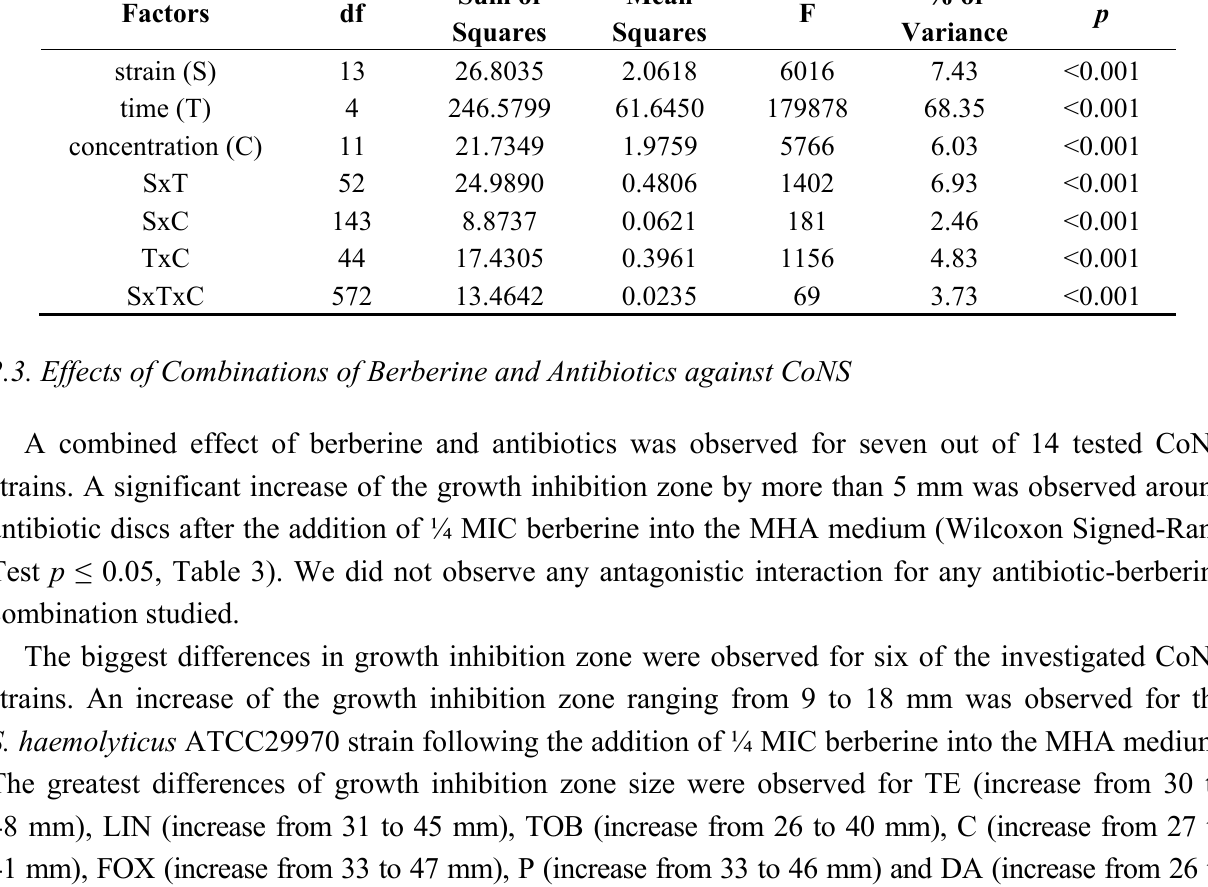
% of Sum of Mean F Variance Squares Squares